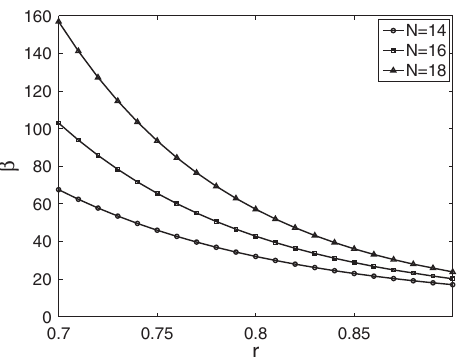
FIG. 2. (cid:5) , the electric field enhancement factor as a function of ratio r for three different values of point charge number N